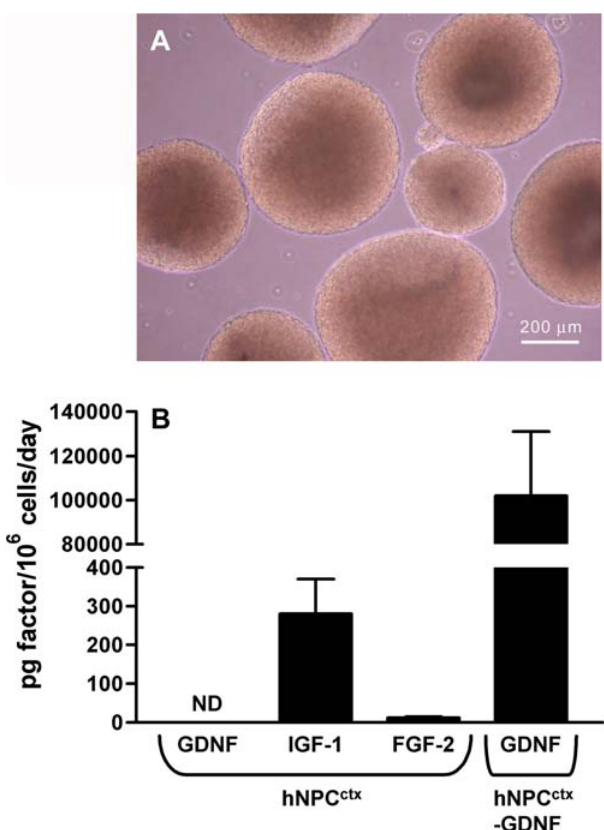
Figure 1. Unmodified and transgenic human neural progenitor cells secrete neuroprotective factors in vitro. (A) Light microscopic appearance of neurospheres cultured from human prenatal cortical progenitor cells (hNPC ctx ). Transgenic neurospheres formed following infection of dissociated hNPC ctx with a lentiviral vector encoding GDNF had an identical appearance in culture. (B) ELISA results quantifying the release of GDNF, IGF-1 and FGF-2 into conditioned media from hNPC ctx and hNPC ctx –GDNF cultures. IGF-1 and FGF-2 were secreted by hNPC ctx , while GDNF was only detectable in transgenic hNPC ctx -GDNF cultures. Data are expressed as mean 6 SEM from n =3–6 independent samples. (ND: not detectable). doi:10.1371/journal.pone.0000338.g001 PLoS ONE |